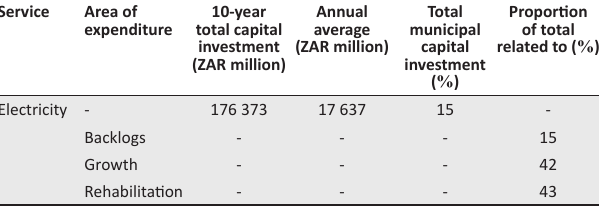
TABLE 1: Projected 10-year capital investment in municipal